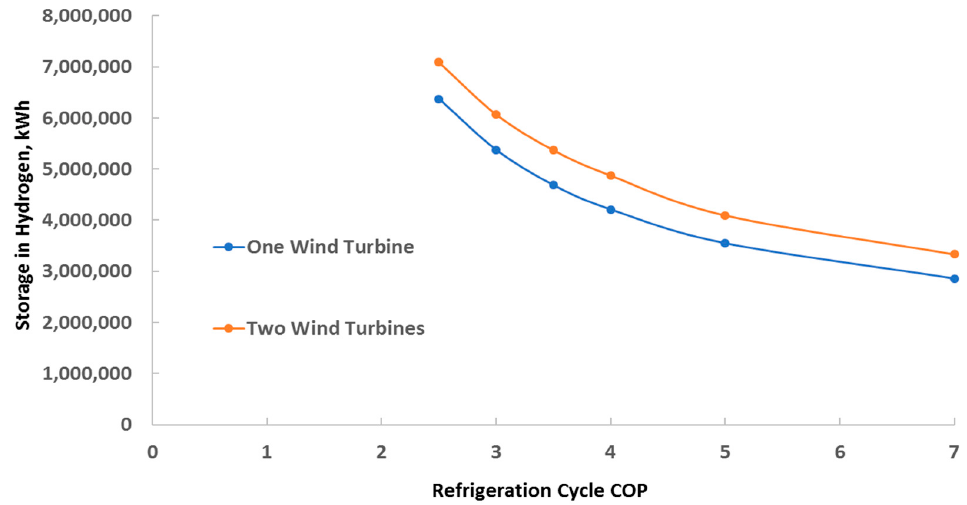
Figure 4. Energy storage requirements for the cluster of the GIBs.